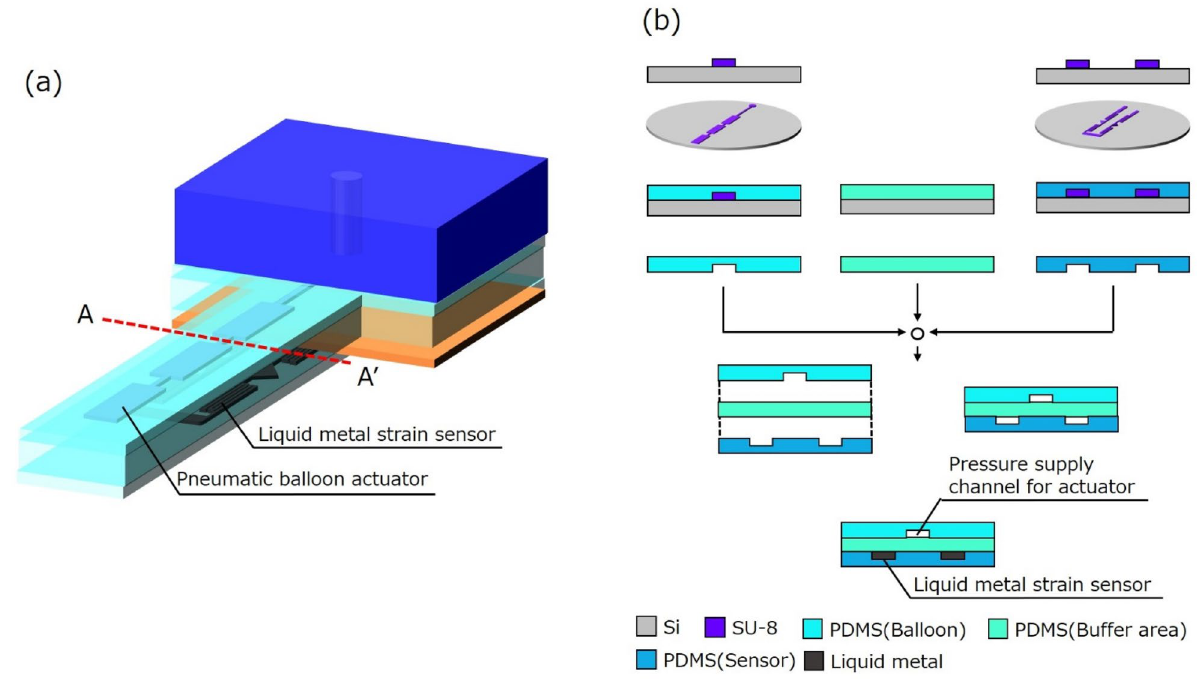
Figure 7. Fabrication process of the microfinger integrated with PBA and a liquid metal-based sensor. ( a ) Schematic image of the microfinger. ( b ) Fabrication process using cross sections along A–A’ in Fig. 7a. Three PDMS layers are bonded to form spaces for microchannels. The resistive strain sensor is completed by filling liquid metal in the